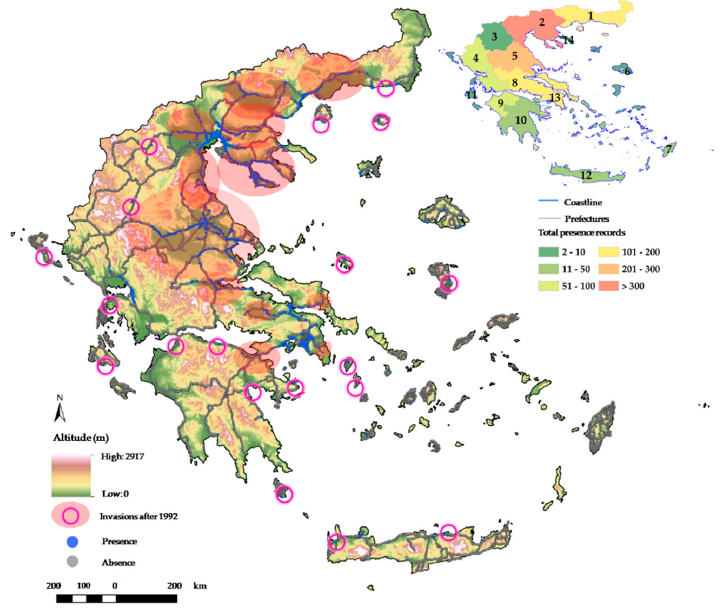
Figure 1. Presence (blue) and absence (grey) records of Solanum elaeagnifolium in the studied area of Greece, indicating the invaded and noninvaded areas in Greece with emphasis on invasions that occurred after the last published inventory in 1992 [20], and total presence records of S. elaeagnifolium per administrative region (NUTS 2) of Greece. 1: Eastern Macedonia-Thraki; 2: Central Macedonia; 3: Western Macedonia; 4: Epirus; 5: Thessaly; 6: North Aegean Islands; 7: South Aegean Islands; 8: Central Greece; 9: Western Greece; 10: Peloponnese; 11: Ionian Islands; 12: Crete; 13: Attica; 14: Agion Oros (semi-independent monastery